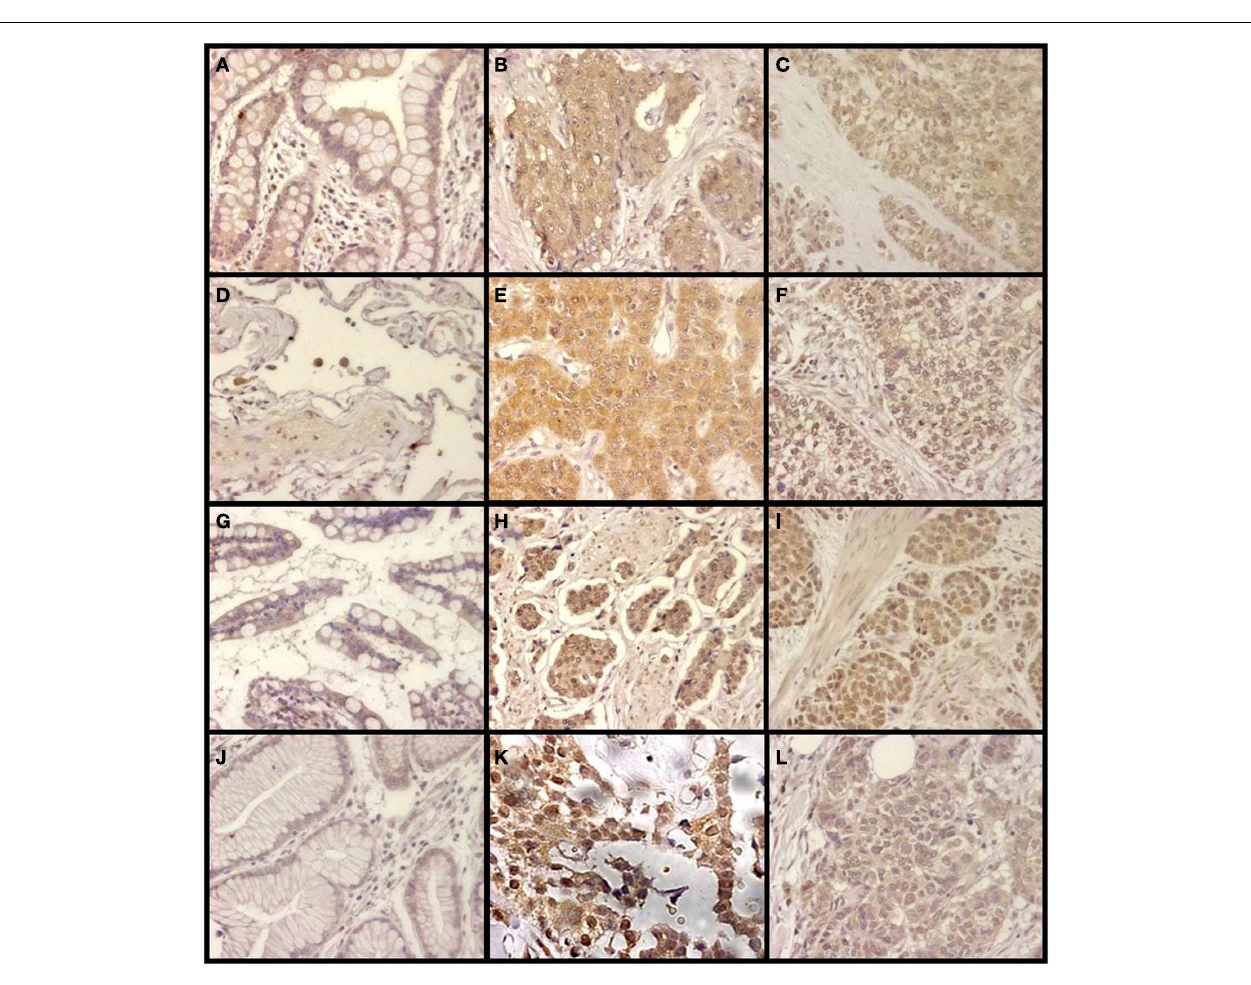
and pancreas (L) . Syndecan 2 antibody marks normal epithelial cells, namely intracryptic cells, with faint cytoplasmic staining.The marking is enhanced in low degree NETs, decreasing in those NETs with the highest degree of malignancy (neuroendocrine carcinomas). Magnification 200 × .